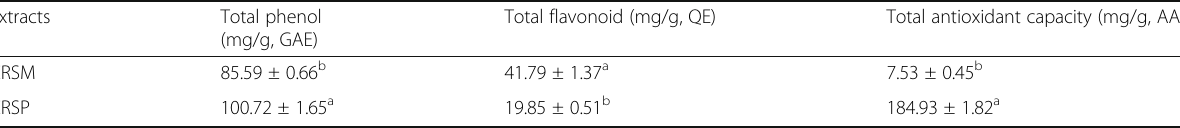
Values are the mean of duplicate experiments and represented as mean±SD ( n =2). Values in same column with different superscripts are significantly different ( P <0.05). Student ’ s t-test was performed to analyze this data set. GAE Gallic Acid Equivalent, QE Quercetin Equivalent, AAE Ascorbic Acid